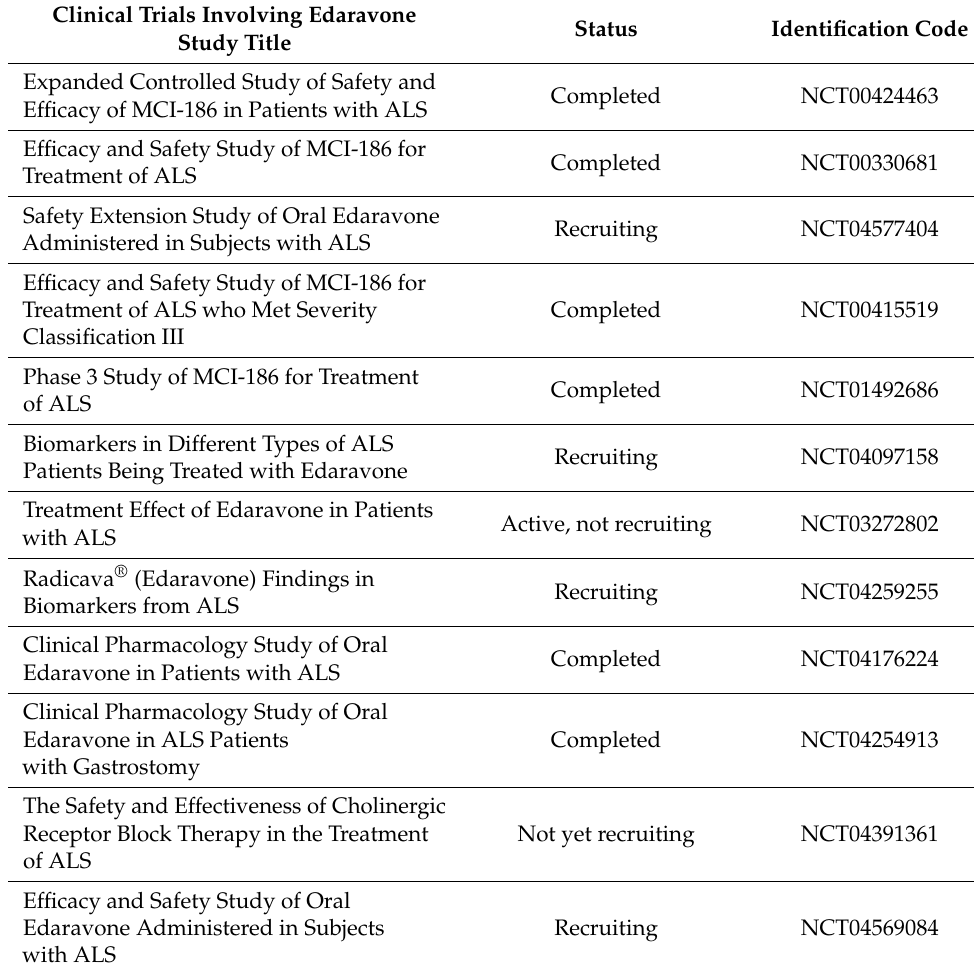
Table 3. Clinical trials of edaravone in ALS patients (data source